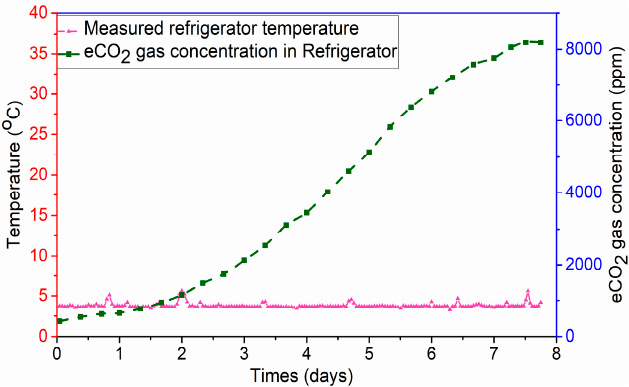
Figure 13. Food monitoring experimental results of measuring temperature and eCO 2 gas Figure13. FoodmonitoringexperimentalresultsofmeasuringtemperatureandeCO 2 gasconcentrations concentrations refrigerator environments. refrigerator